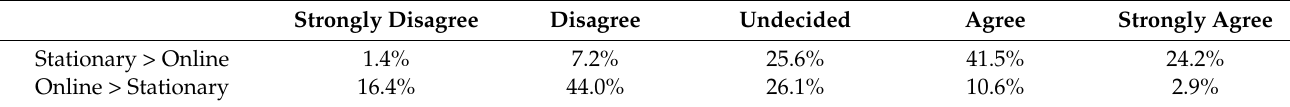
Table 9. Comparison of opinions about face-to-face and remote